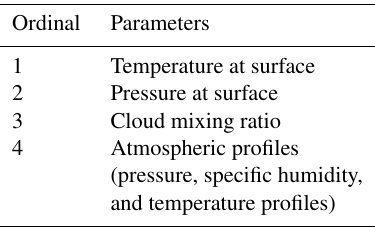
Table 1. Geophysical parameters from the reanalysis datasets used in the